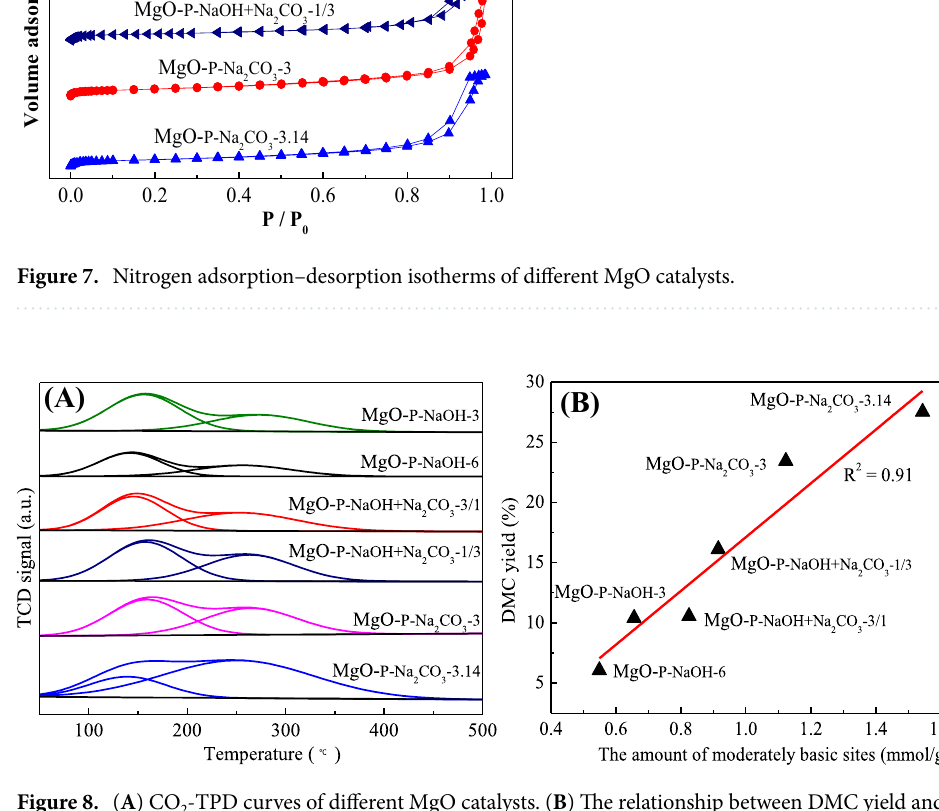
Figure 8. ( A ) CO 2 -TPD curves of different MgO catalysts. ( B ) The relationship between DMC yield and amount of moderately basic sites of various MgO